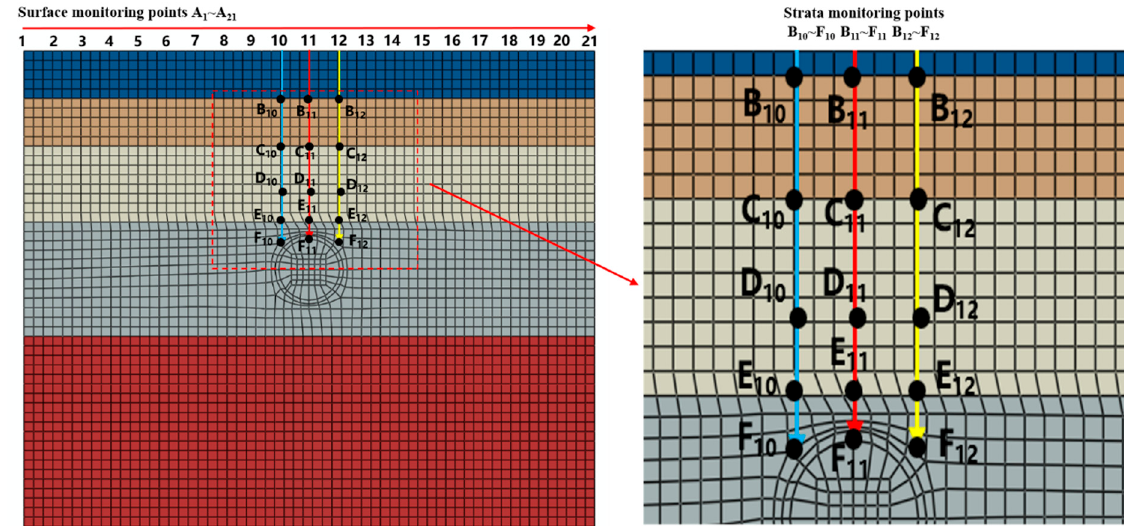
Figure 4. Numerical simulation monitoring point layout diagram.